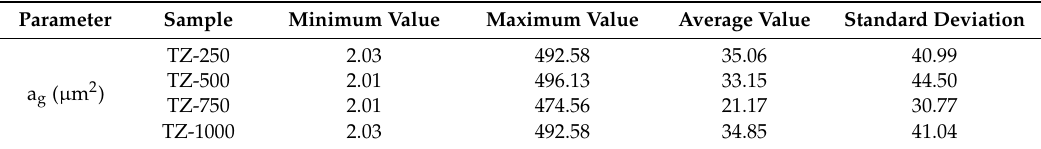
Table 3. Results of the section area of the grains for the samples manufactured under di ff erent pressure